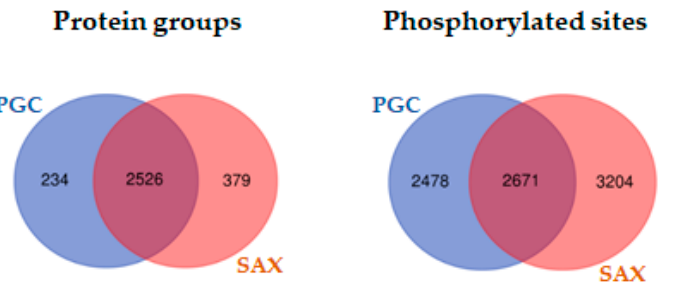
Figure 3. Venn diagrams. Comparison of the overlap between the identified phosphosites regard- ing the level of protein groups and phosphosites for samples fractionated by PGC and